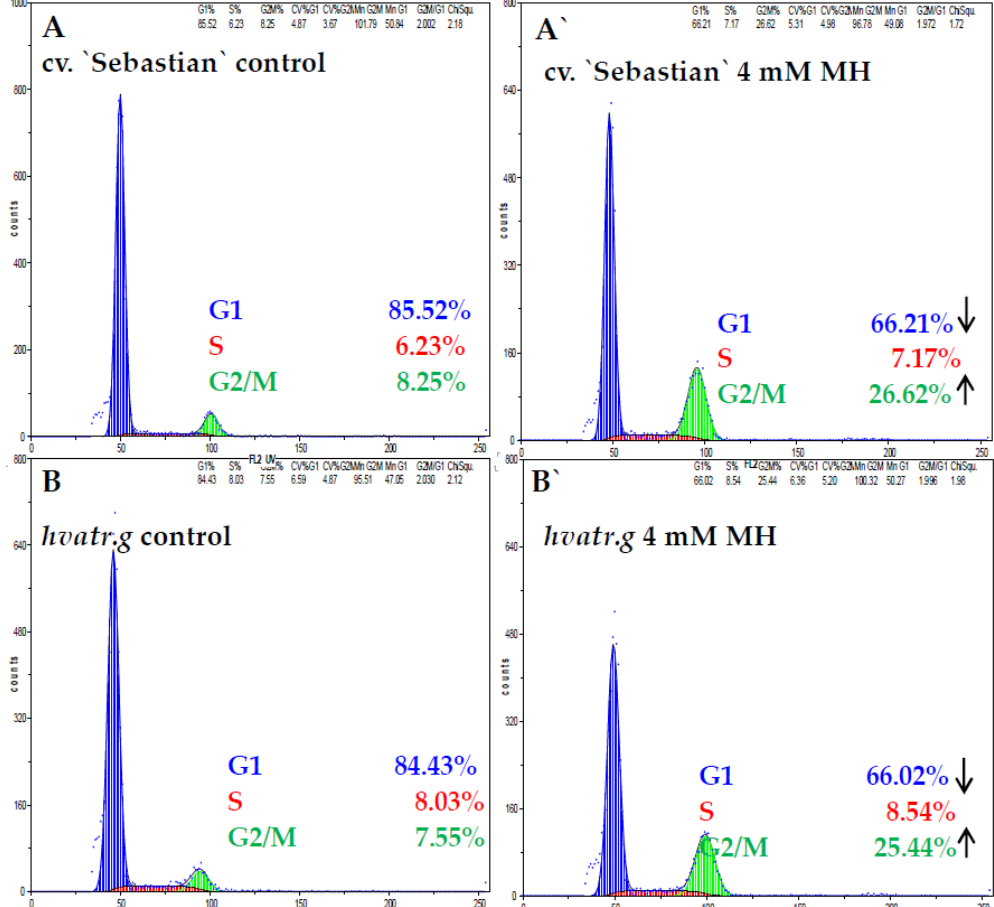
Figure 7. Flow cytometric analysis of the cell cycle in roots of barley cv. “Sebastian” ( A , A’ ) and hvatr.g mutants ( B , B’ ). ( A , B ) control roots, ( A’ , B’ ) 4 mM MH treated roots.